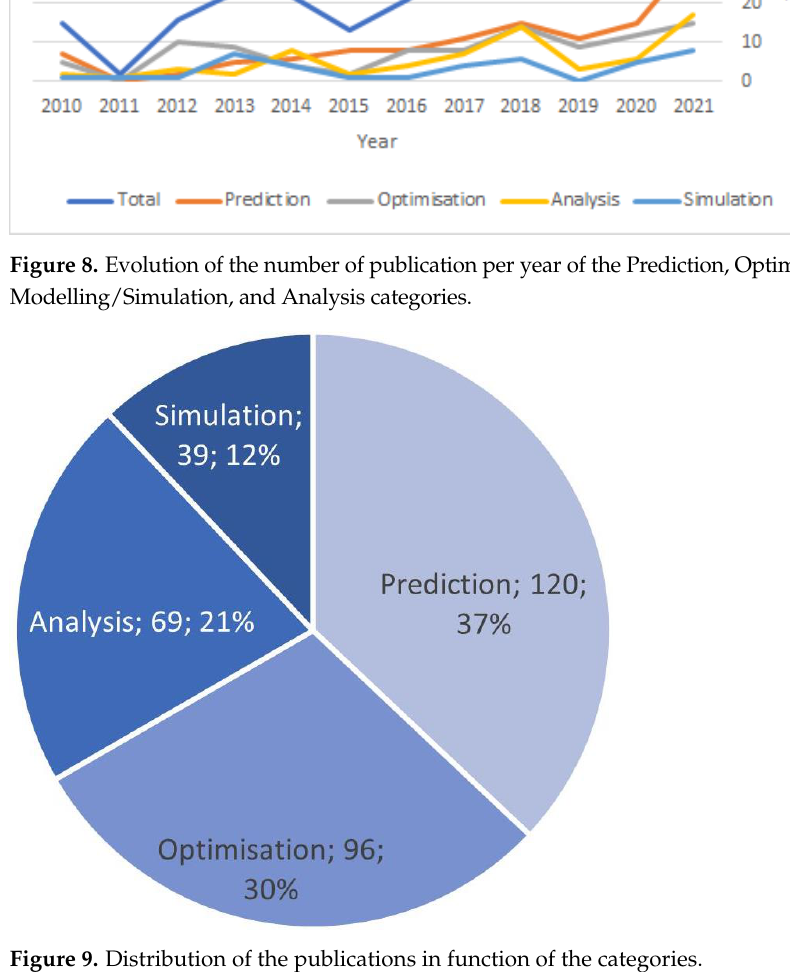
Figure 9. Distribution of the publications in function of the